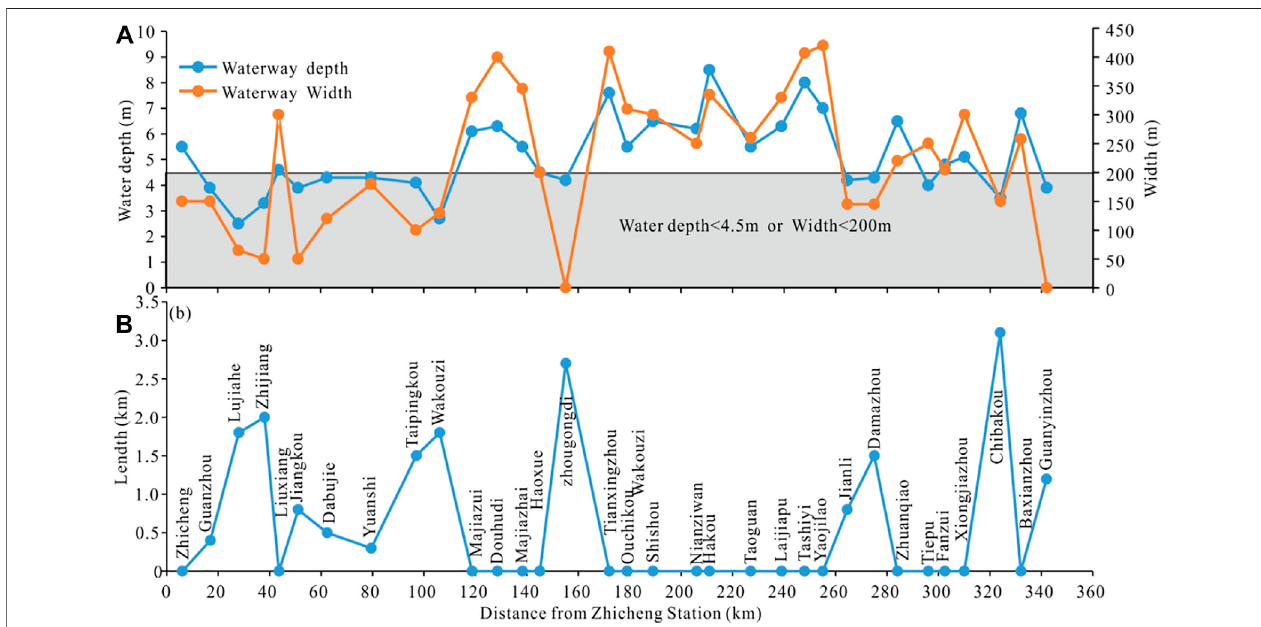
FIGURE 7 | Veri fi cation of waterway conditions; (A) Minimum water depth and width; (B) Length not meeting 4.5 × 200 m.